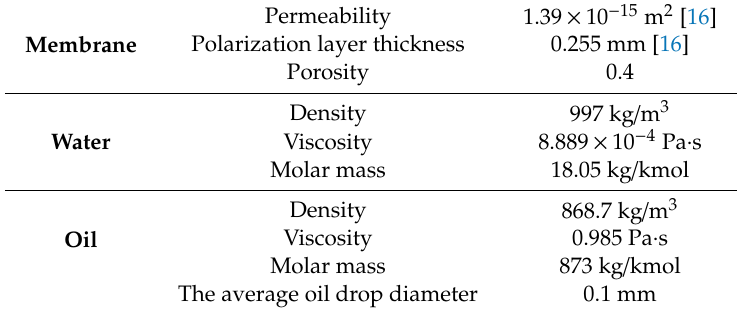
Table 2. Thermal, physical, chemical and geometrical parameters of the porous wall and mixture fluids (T = 293.15